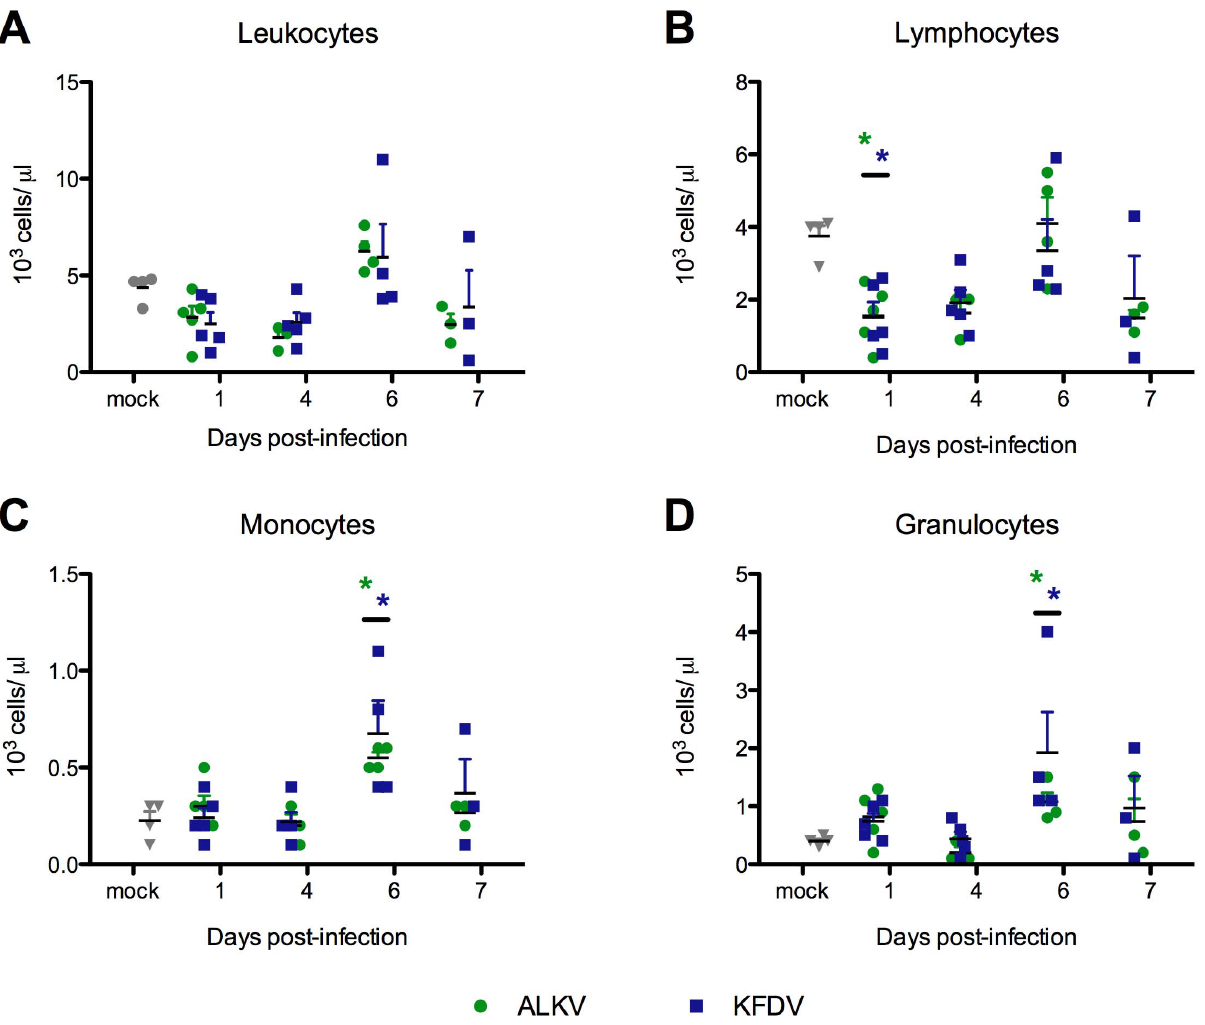
Figure 3. KFDV and AHFV-infected mice developed significant lymphopenia relative to control mice. Complete blood counts were run on KFDV-, AHFV- and mock-infected mice on 1, 4, 6, and 7 dpi. (A) Leukocyte, (B) lymphocyte, (C) monocyte and (D) granulocyte counts are displayed. Asterisks indicate significant differences between KFDV-infected mice (blue) or AHFV-infected mice (green) relative to mock-infected animals (p , 0.05). On each day, data was collected from a minimum of 3 and a maximum of 5 mice per group. hypoalbuminemia (Figure 4E) and hypoglycemia (Figure 4F) were apparent in KFDV mice. In contrast, all chemistry values from AHFV-infected mice were indistinguishable from mock-infected mice.